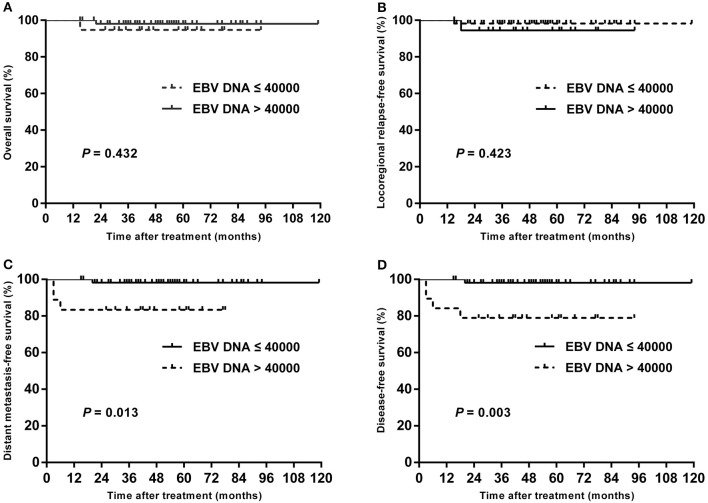
Kaplan–Meier estimate of the OS (A), LRRFS (B), DMFS (C), and DFS (D) of T1–T3 children and adolescent NPC patients according to pretreatment EBV DNA levels.